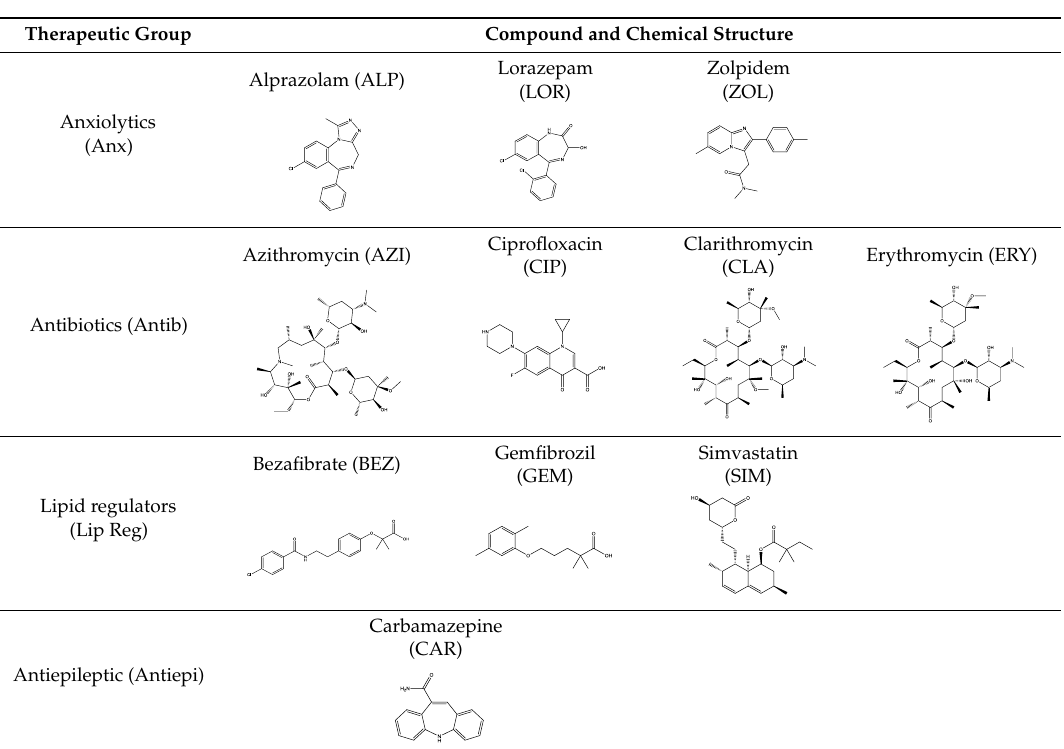
Table 1. Selected